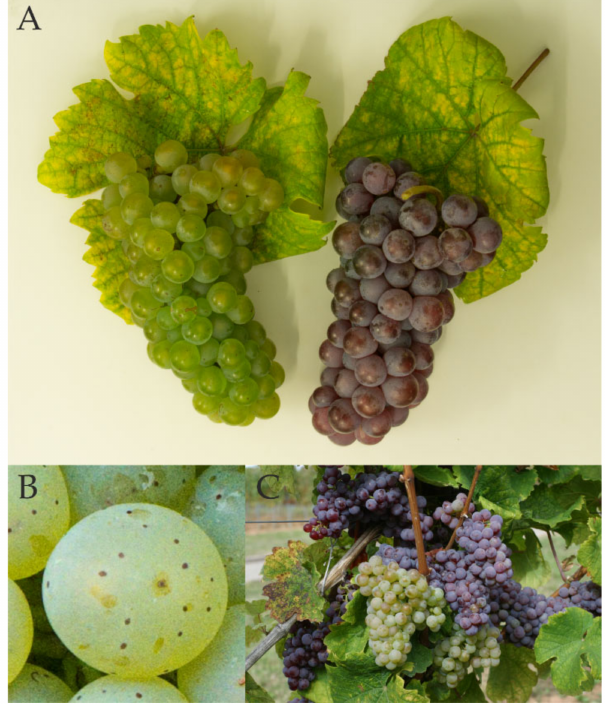
Figure 1. ( A ) Ripe grape bunches of ‘Riesling Weiss’ and ‘Riesling Rot’. ( B ) Ripe ‘Riesling Weiss’ berry with clearly visible lenticels. ( C ) ‘Riesling Rot’ with the typical red bunches and two mutated white bunches on a single fruit